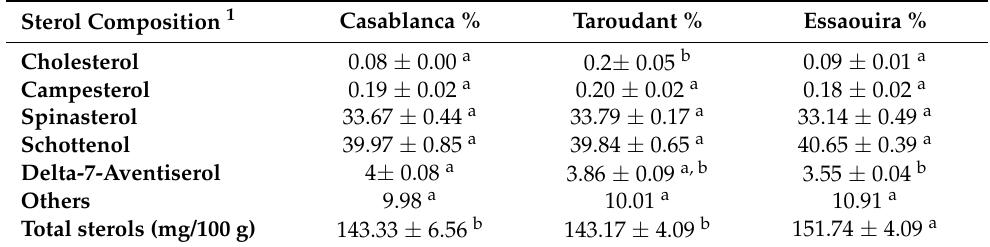
Table 3. Comparison of sterol concentration (%) of argan oil from argan trees grown on a plantation (Casablanca: AOC) and in two natural forest stands (Taroudant: AOT and Essaouira: AOE). Sterol Composition 1 Casablanca % Taroudant % Essaouira % Cholesterol 0.08 ± 0.00 a 0.2 ± 0.05 b 0.09 ± 0.01 a Campesterol 0.19 ± 0.02 a Spinasterol 33.67 ± 0.44 a Schottenol Delta-7-Aventiserol Others Total sterols (mg/100 g) 143.33 ± 6.56 b 151.74 ± 4.09 a 1 Mean values ± standard deviation ( n = 2). Values in the same column with different letters are significantly different at p < 0.05, according to the Bonferroni test.